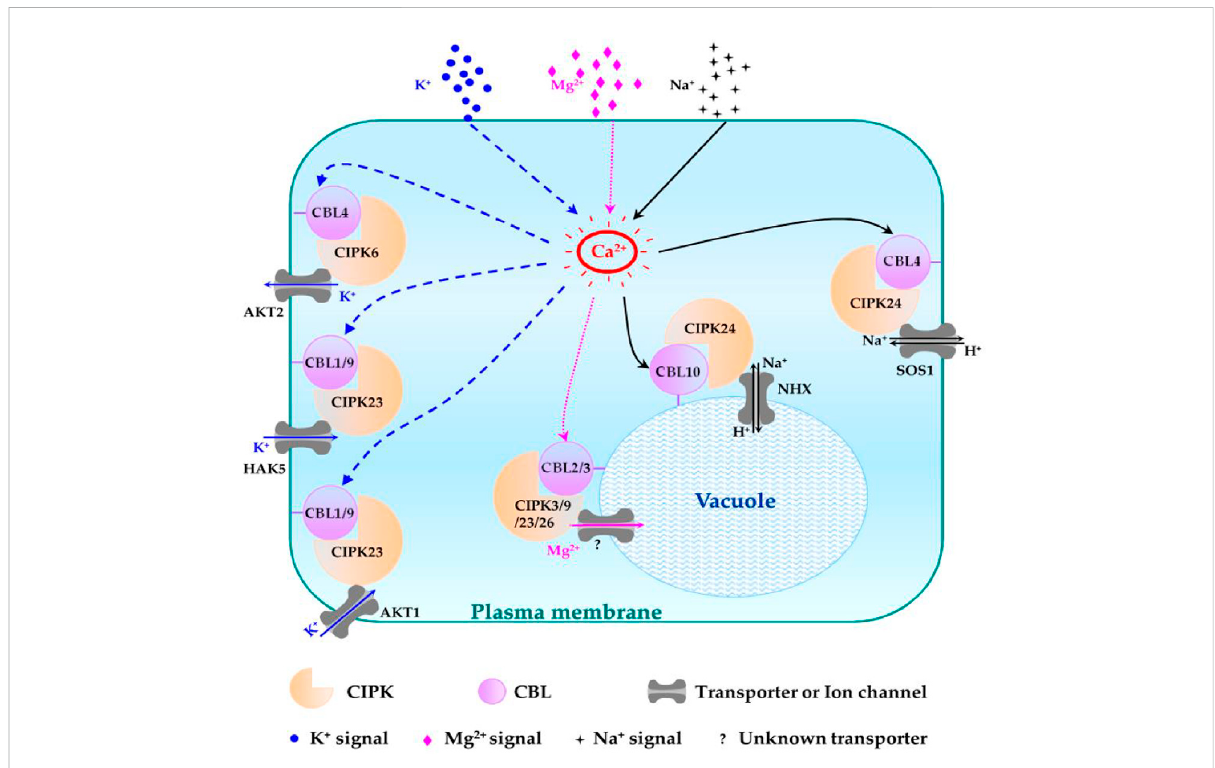
FIGURE 6 Schematic representation of different CBL-CIPK complexes and their functions in regulating Na + , K + , and Mg 2+ homeostasis. The regulatory pathways of K + , Mg 2+ , and Na + are indicated in blue, pink, and black lines, respectively. Question mark (?): unknown tonoplast-localized transporter (Mao et al.,